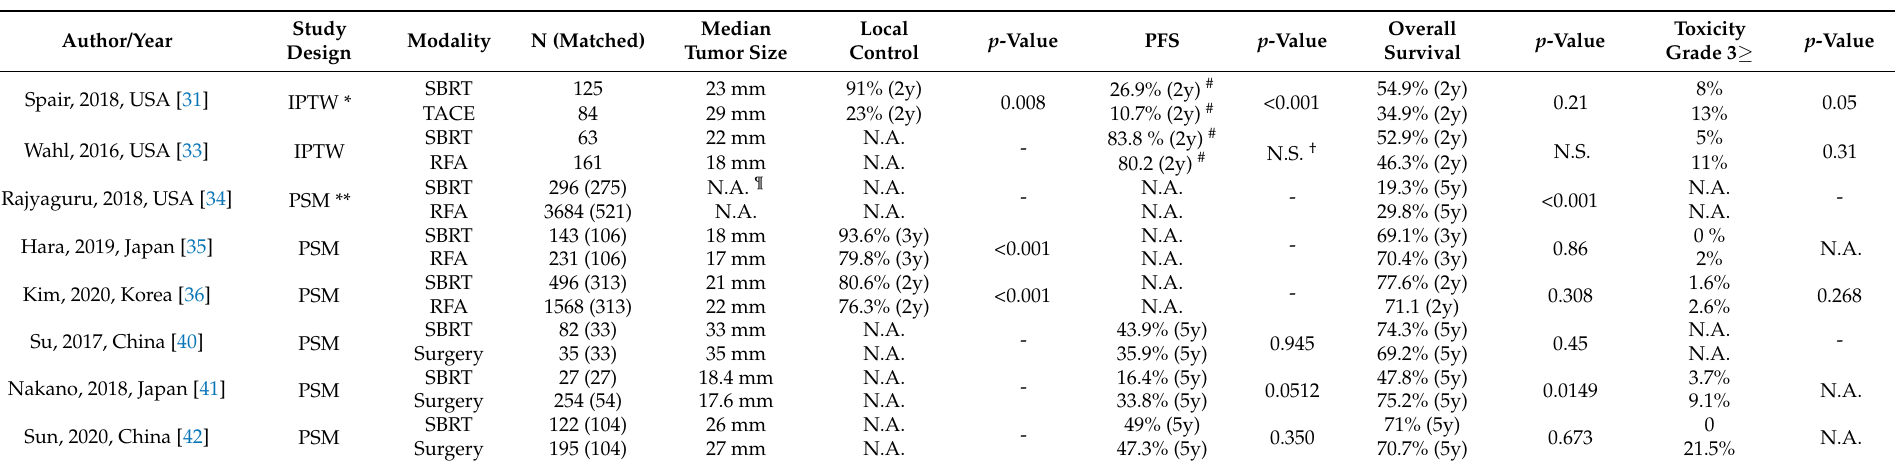
Table 2. Comparison with the other